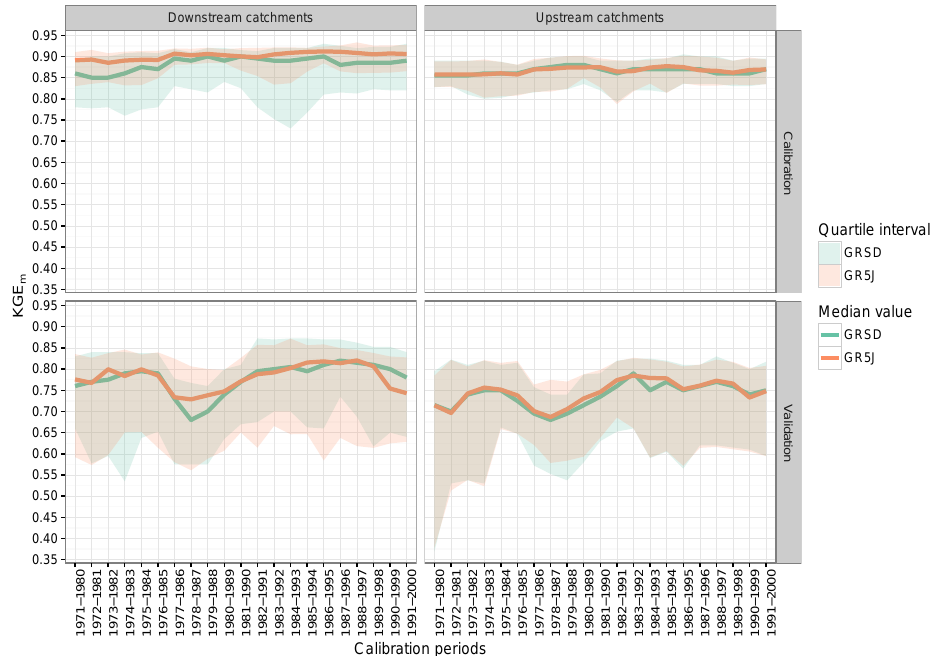
Figure 4. Quantile values of the goodness-of-fit (KGE m ) during calibration and validation over the 64 catchments for the lumped model (GR5J) and the semi-distributed model (GRSD) along the 21 calibration periods. Upstream catchments are all headwater hydrological units, and downstream catchments are all the others.